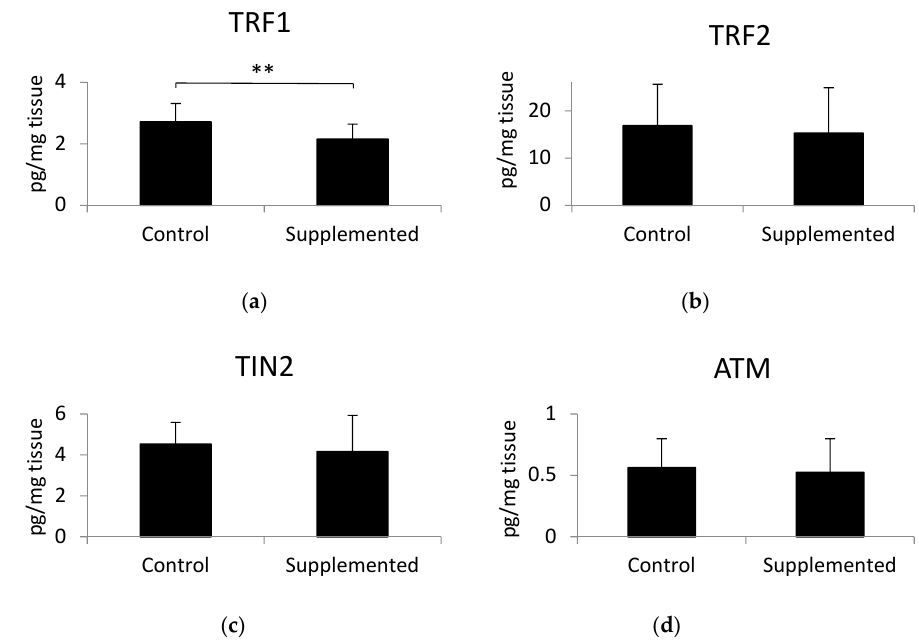
Figure 2. Levels of ( a ) telomere repeat factor- 1 (TRF1), ( b ) telomere repeat factor-2 (TRF2), ( c ) TRF1-interacting protein 2 (TIN2), and ( d ) ATM kinase in muscle samples, determined using ELISA tests. Values are the mean +/ − standard deviation. Statistical differences were analyzed using the unpaired t -test. Differences of p < 0.05 were considered statistically significant, ** p < 0.01.